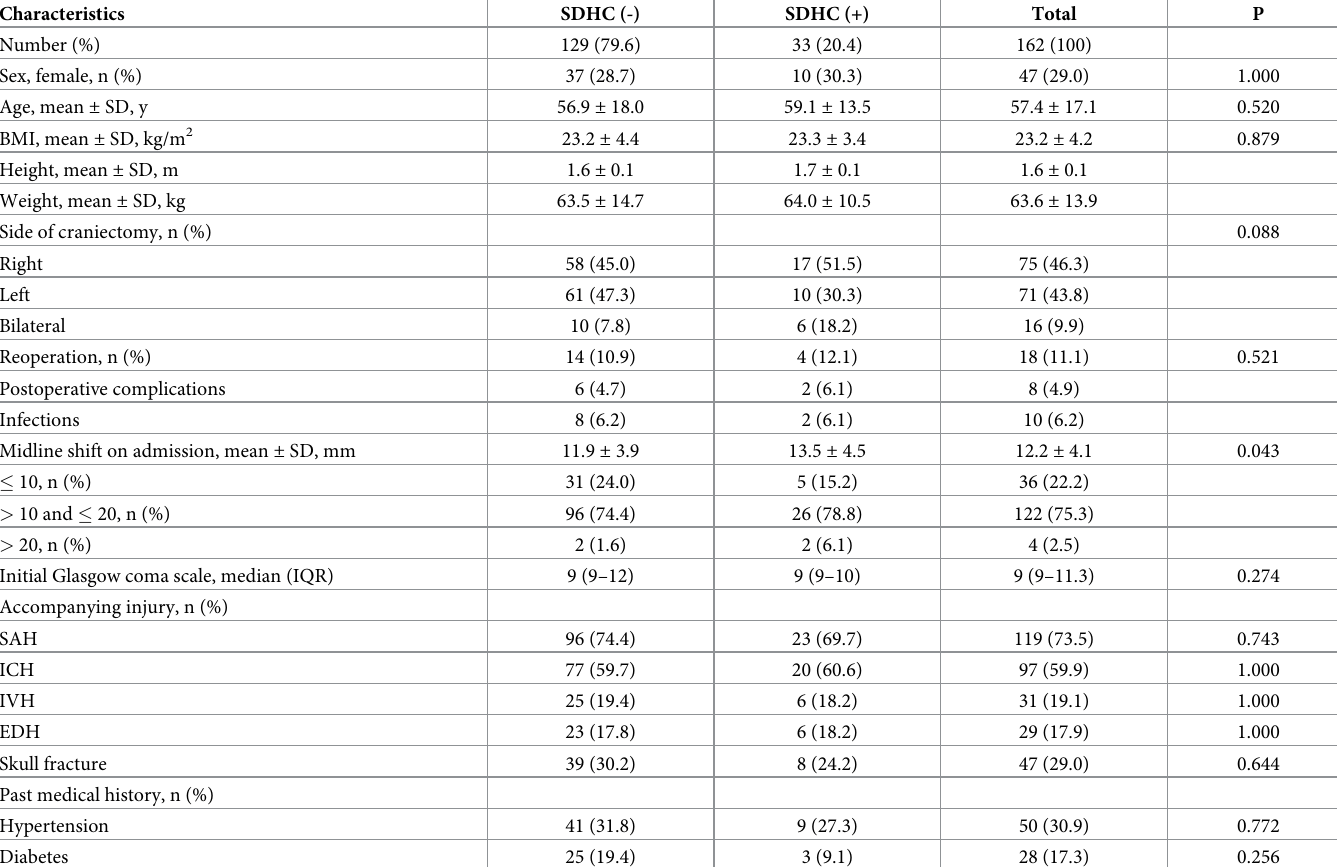
Table 1. Clinical characteristics of patients ultimately receiving cranioplasty after craniectomy due to traumatic subdural hematoma classified according to shunt- dependent hydrocephalus in the study cohort.